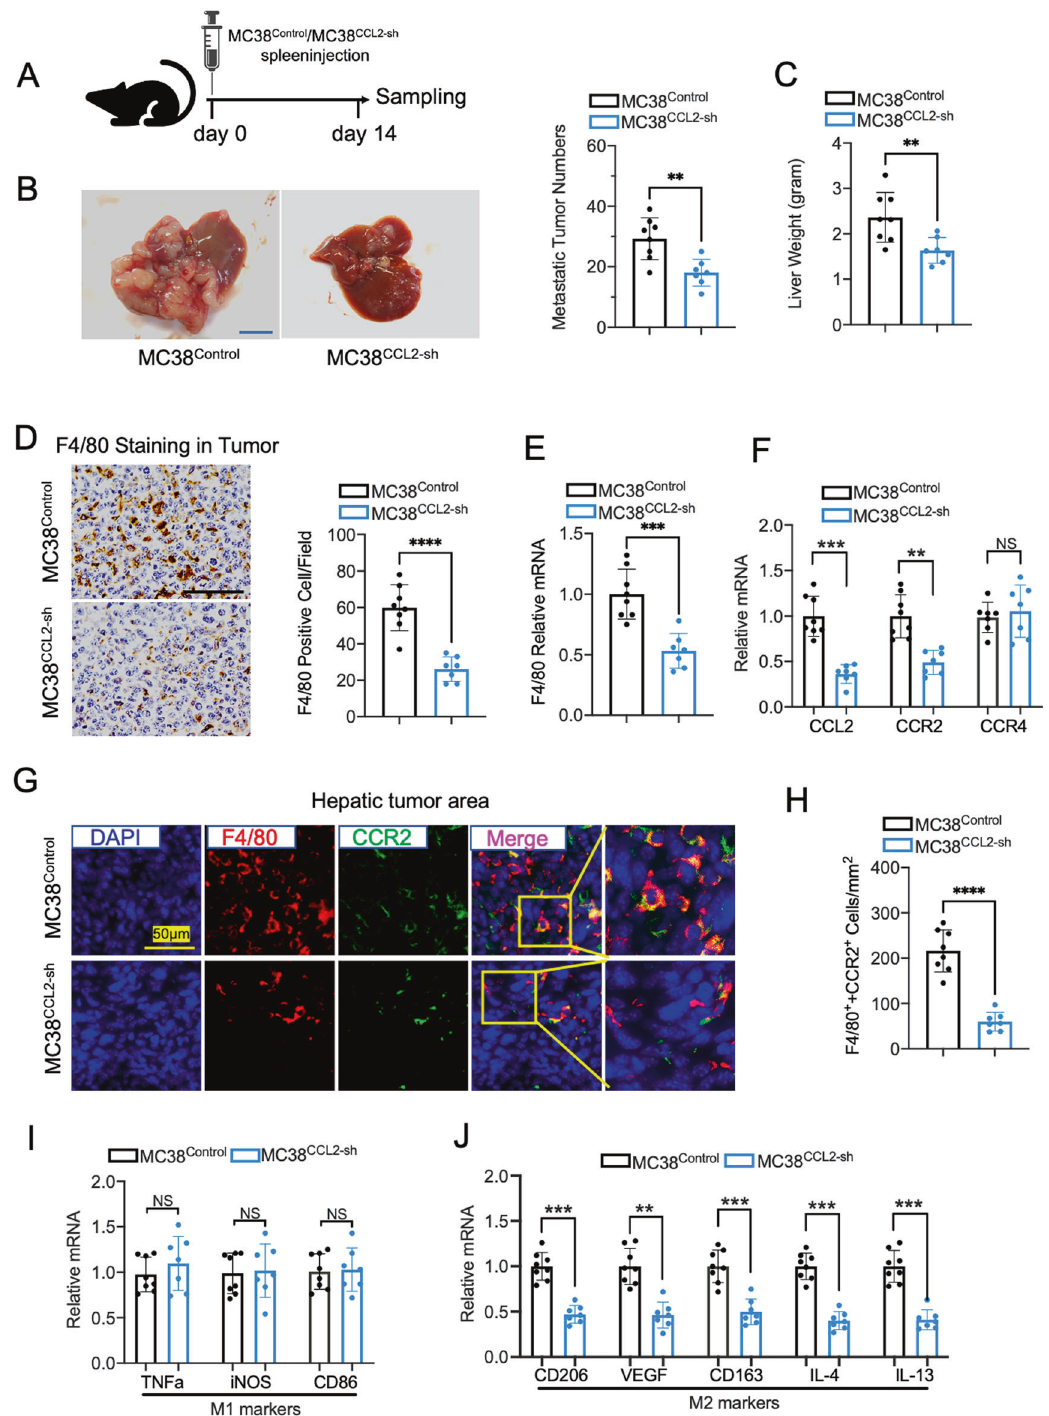
Fig. 7 Silencing of CCL2 in MC38 cells inhibits hepatic tumor growth through regulation of TAM recruitment and polarization in mouse model. A The schematic protocol of the mouse model received MC38 spleen injection. B Representative images and tumor nodule numbers of mouse liver with colorectal cancer metastases. MC38Control group, n = 8; MC38CCL2-sh group n = 7; Scale bar, 10 mm. C The liver weight of the mice was evaluated. D F4/80 Immunohistochemistry staining and quanti fi cation in the metastatic tumor region. MC38Control group, n = 8; MC38CCL2-sh group n = 7; Scale bar, 100 μ m; fi ve fi elds were counted per sample. E F4/80 mRNA expression in the tumor was analyzed by Q-PCR. F Q-PCR analysis of CCL2, CCR2, and CCR4 mRNA expression in the tumors. G Representative images of Immuno fl uorescence staining for F4/80(red), CCR2(green) and DAPI(blue) in mouse hepatic metastases. Scale bar, 50 μ m. H Quanti fi cation of F4/80 and CCR2 double positive cells per mm2 tumor area. MC38Control group, n = 8; MC38CCL2-sh group n = 7; fi ve fi elds were counted per sample. I mRNA expression of M1 macrophage markers in tumors. J M2 macrophage markers CD206, VEGF, CD163, IL-4, IL-13 mRNA expression in tumors. Data are means ± SEM. * P < 0.05, ** P < 0.01, *** P < 0.005, **** P < 0.001.